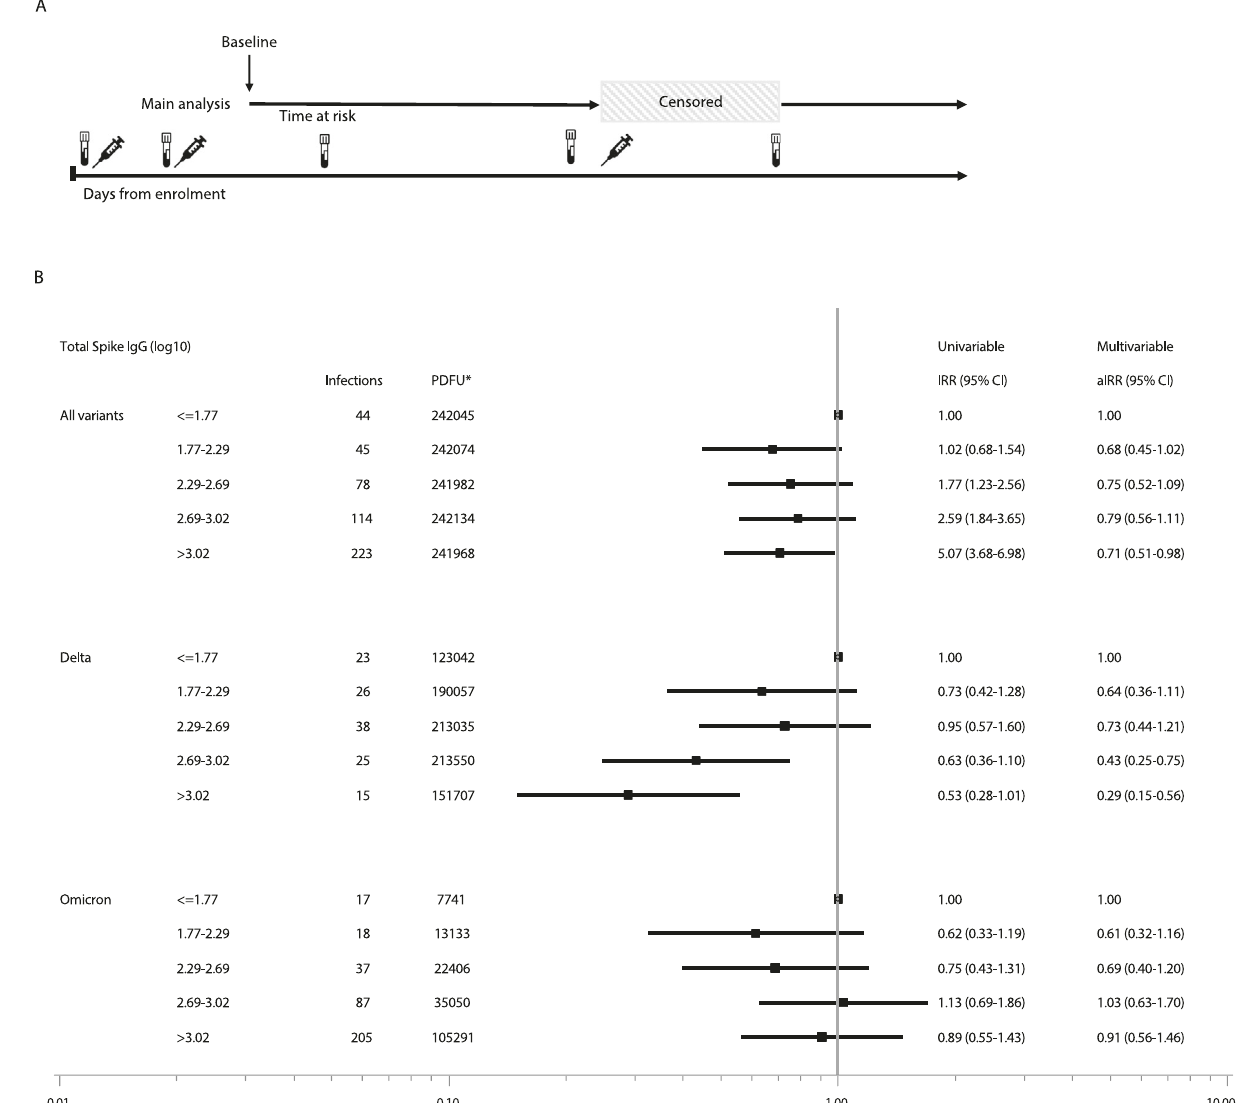
Fig. 1 | Main analysis adjusted and unadjusted incidence rate ratios for break- through infection. A Schematic overview of the analysis design. The syringe icon represents vaccinations, the blood sample icons represent blood draws and the shadedarearepresentsthecensoredtimeperiod.Participantswerecensoredatthe time ofthirdSARS-CoV-2vaccination and re-entered the analysis atthe time ofthe post-booster blood draw. B Forest plot of the adjusted incidencerate ratios (aIRR) forbreakthroughinfections.Incidencerateratios(IRR)andadjustedincidencerate ratios (aIRR) for breakthrough infections calculated using a Poisson regression analysisfor eachquintile of SARS-CoV-2 anti-spike IgGlog 10 BAU, strati fi edbyviral